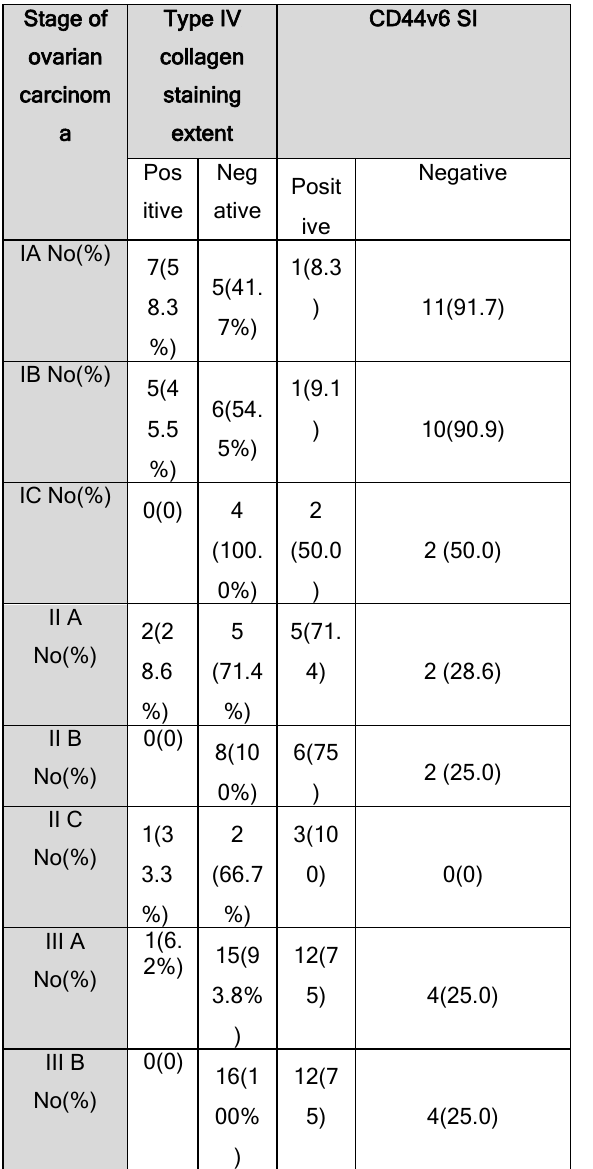
Table 4: Association of type IV collagen and CD44v6 immunohistochemical expression with stage of ovarian carcinoma Stage of ovarian carcinom